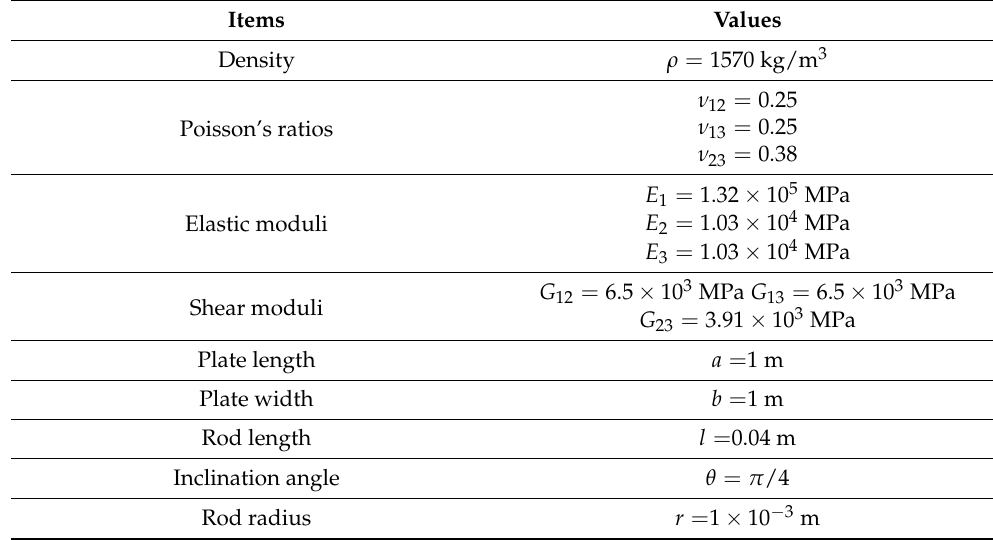
Table 2. Geometry and material property parameters of the sandwich